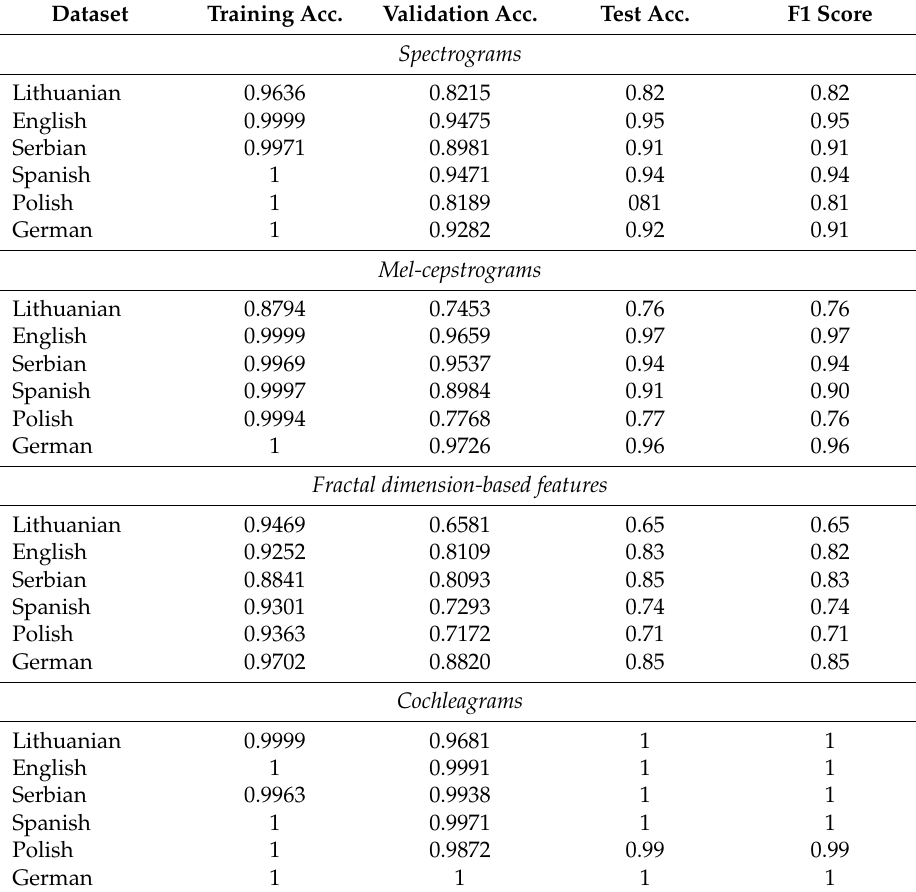
Table 3. Classification results.